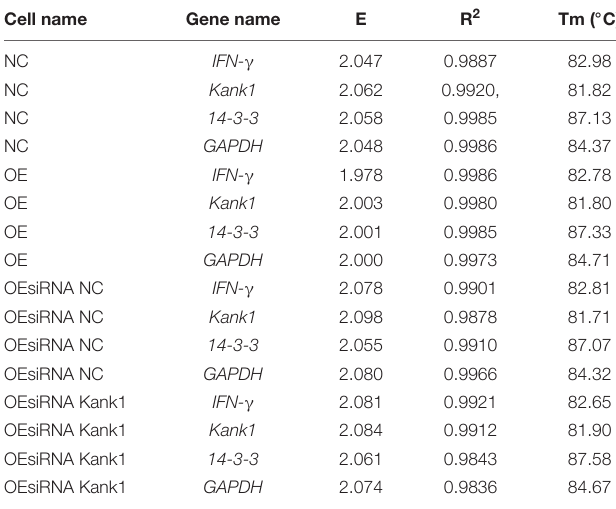
TABLE 2 | The standard curve indexes of IFN- γ , Kank1,14-3-3 and GAPDH genes in four different cells were shown